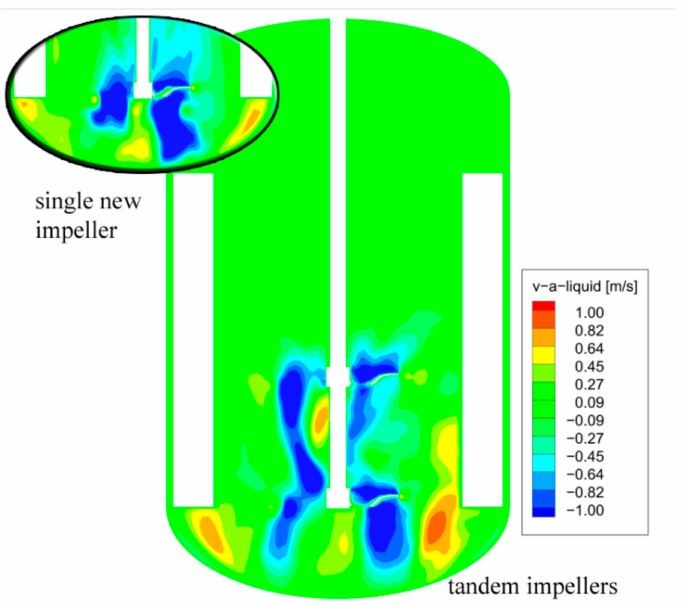
Figure 4. Axial velocity distribution of liquid phase, single new impeller vs. new impellers in tandem, instantaneous